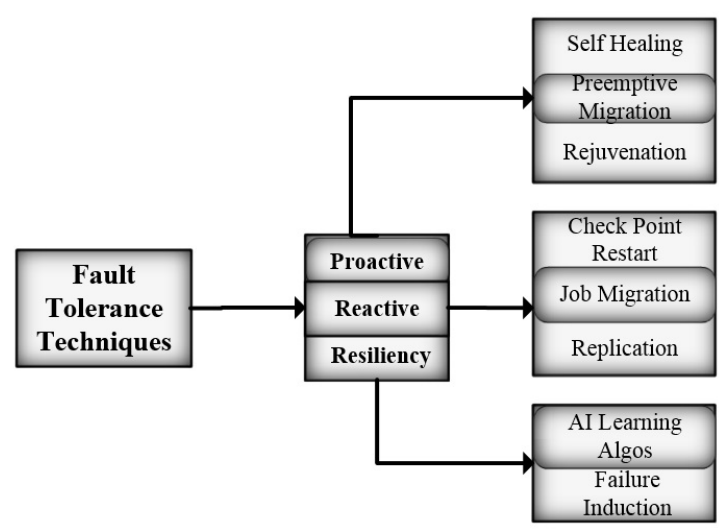
Figure 1. Fault tolerant